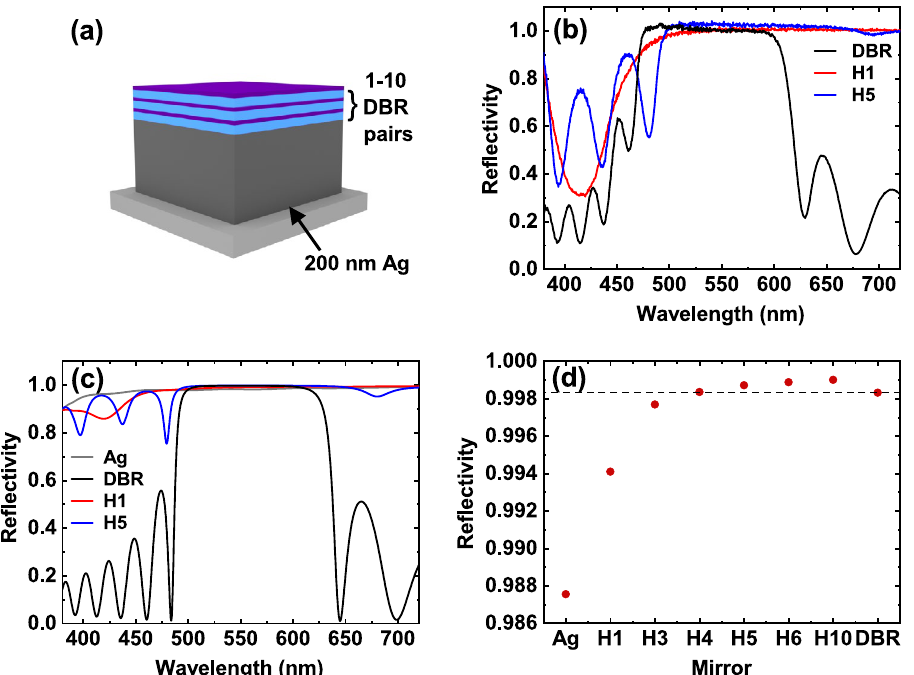
Figure 1. Hybrid metal-DBR mirrors. ( a ) Schematic of hybrid mirror. ( b ) Shows the experimentally measured reflectivity of the 1-pair hybrid (red), 5-pair hybrid (blue) and 10-pair DBR (black) mirrors, with transfer matrix reflectivity data for the same mirrors plus Ag (grey) shown in ( c ). ( d ) Plots the calculated reflectivity of each mirror at 550 nm. The horizontal dashed black line corresponds to the reflectivity of a 10-pair DBR. In ( b – d ), legend and x-axis labels ‘H X ’ correspond to the hybrid mirrors, where X is the number of DBR pairs on top of the Ag, and ‘Ag’ and ‘DBR’ correspond to an Ag film and the 10-pair DBR, respectively.